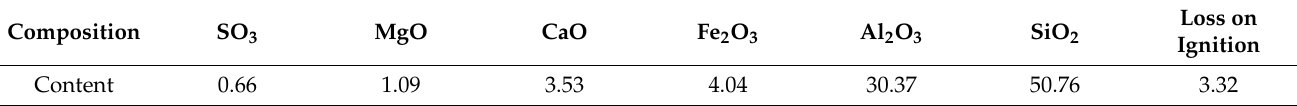
Table 2. Chemical composition of fly ash in HTFC admixtures.